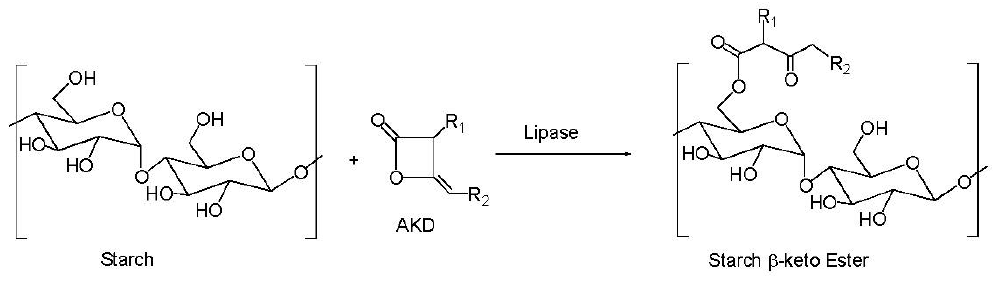
Figure 15. Enzyme-Catalyzed Formation of Starch Alkyl β -Ketone Ester.